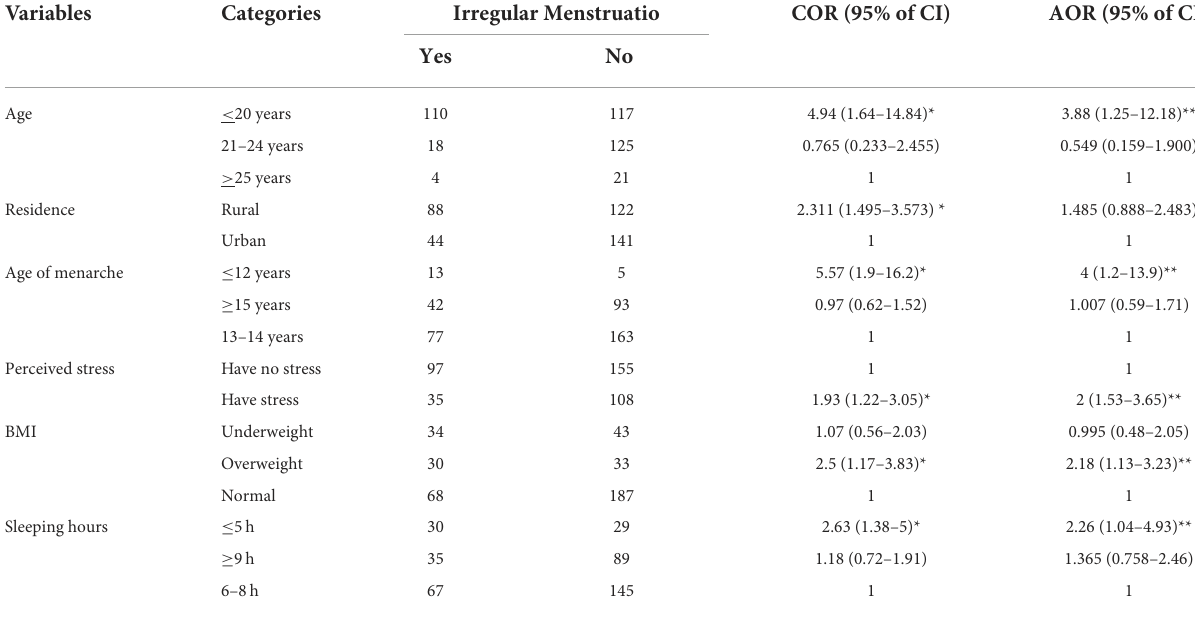
TABLE 3 Factors associated with menstrual irregularity of female college students, Debre Berhan, Ethiopia, 2021 ( n = 395).